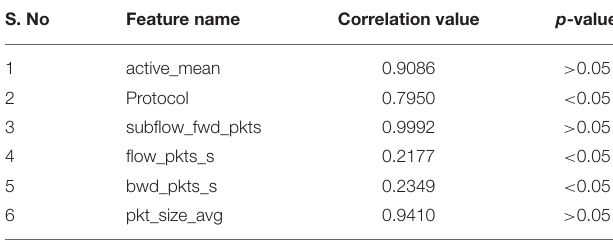
TABLE 2 | Features in CIC IDS 2018 with corresponding correlation values and p -value based significance. S.